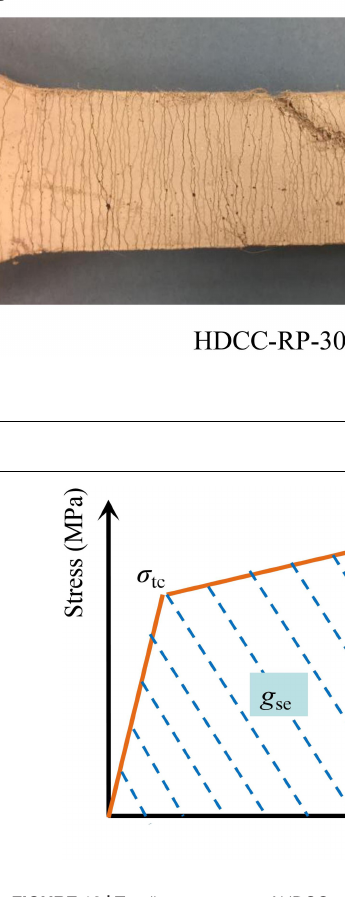
FIGURE 10 | Tensile parameters of HDCCs (Ding et al.,